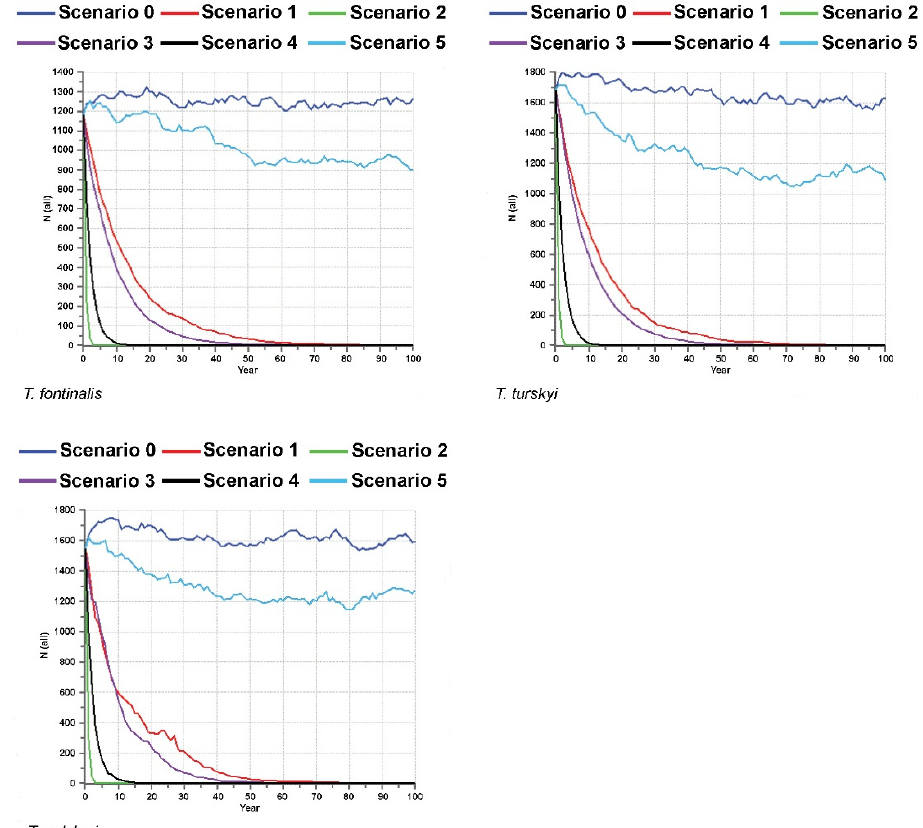
Figure 3. Results of population viability analyses for T. fontinalis , T. turskyi and T. polylepis based on six scenarios.